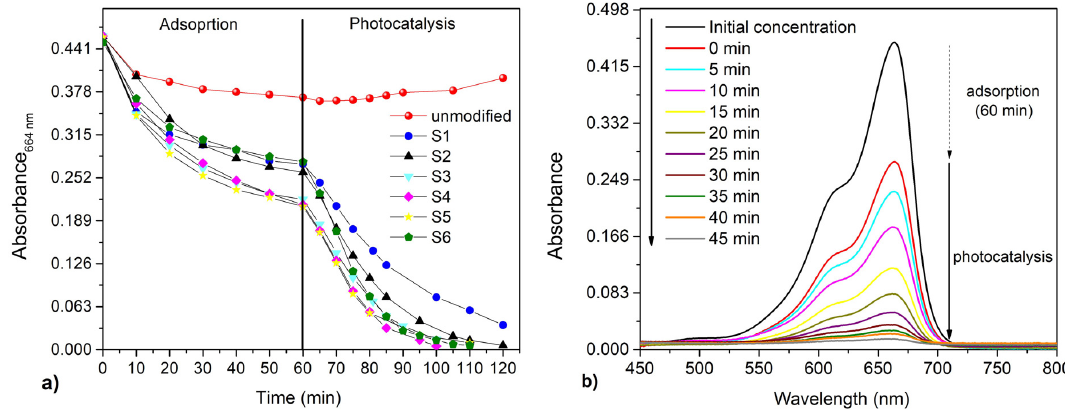
Figure 7. ( a ) Measured absorbance of methylene blue at wavelength 664 nm vs time of the adsorption and photocatalytic processes in the presence of the different samples of fabrics (unmodified and modified S1–6). In the first hour the adsorption was performed in the dark, then the visible light irradiation was used ( λ = 416 nm). ( b ) Typical absorption spectra of the aqueous MB solution in the presence of sample S4. The spectra are reported for the initial concentration of MB (when the MB and the membrane are mixed) to 45 min after irradiation with light (time t = 0 corresponds to the moment the irradiation light was switched on).